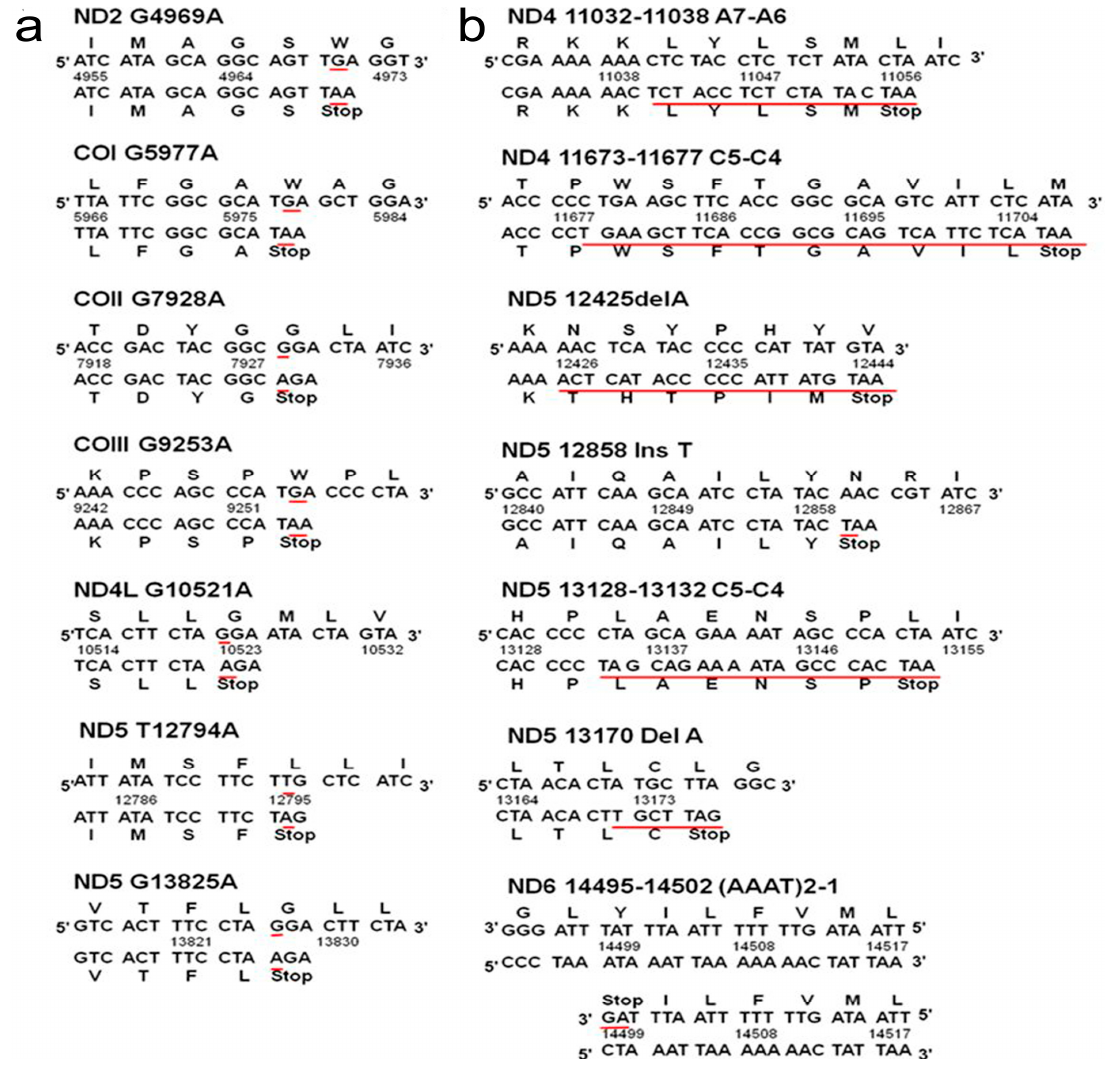
Figure 2. The nonsense and framshift mutations: ( a ) Seven nonsense mutations directly introduce stop-codon and thus create premature termination of protein synthesis immediately; and ( b ) Seven frameshift alterations bring stop-codon in the following transcription and induce truncated polypeptide.